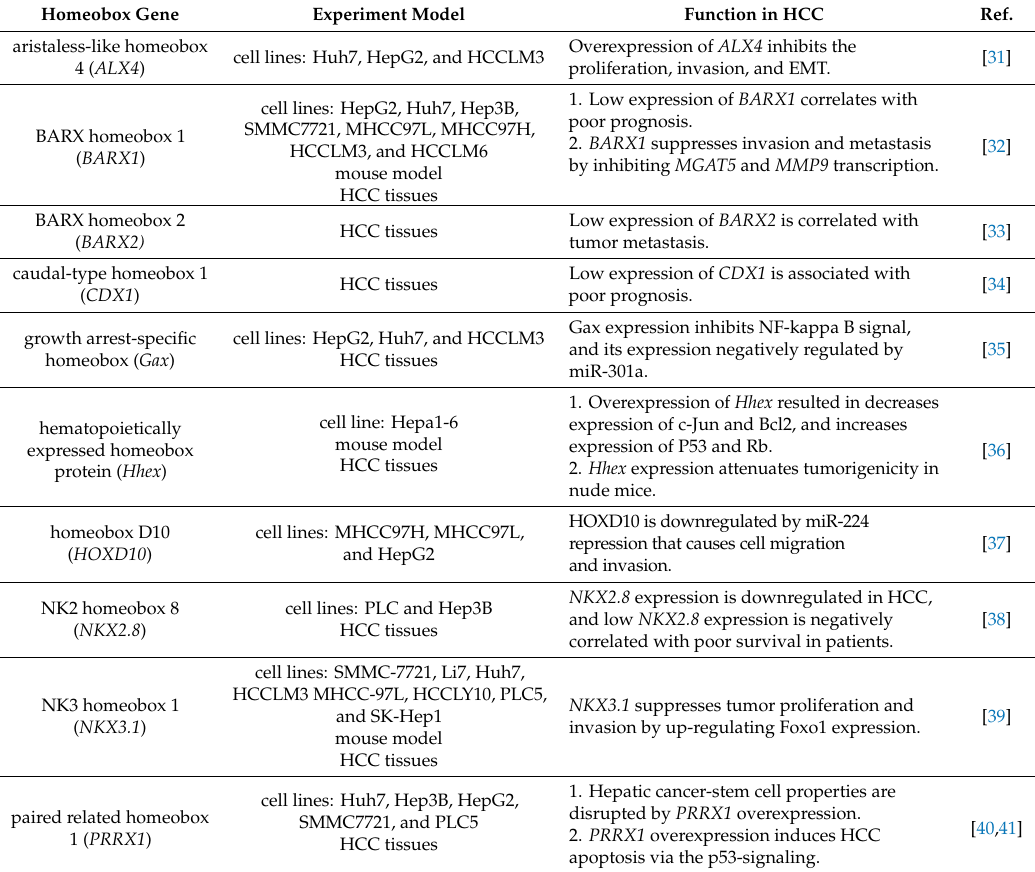
Table 1. Homeobox genes suppress hepatocellular carcinoma (HCC) progression.